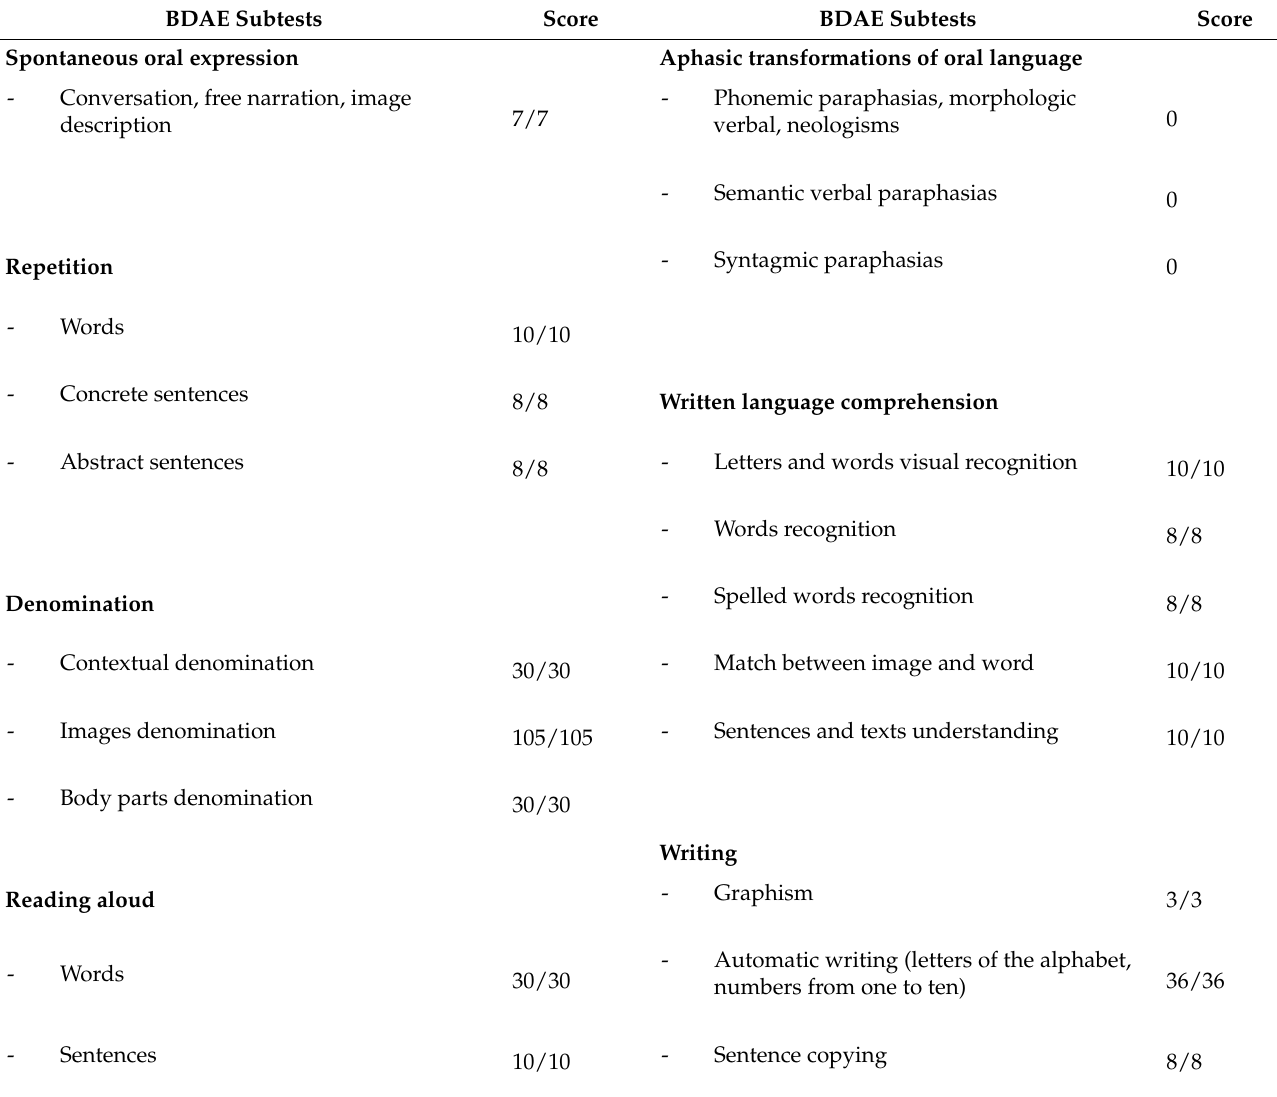
Table 2. Results of the French adaptation of the Boston Diagnostic Aphasia Examination